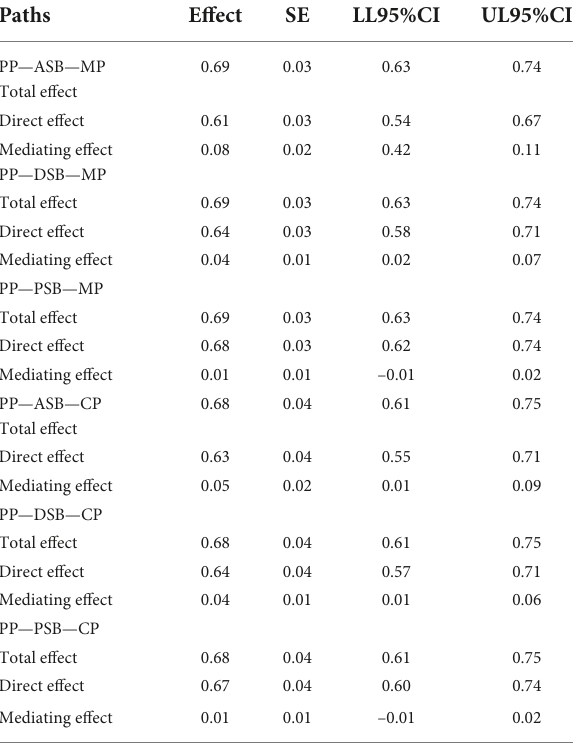
TABLE 6 Total effect, direct effect and mediating effect.